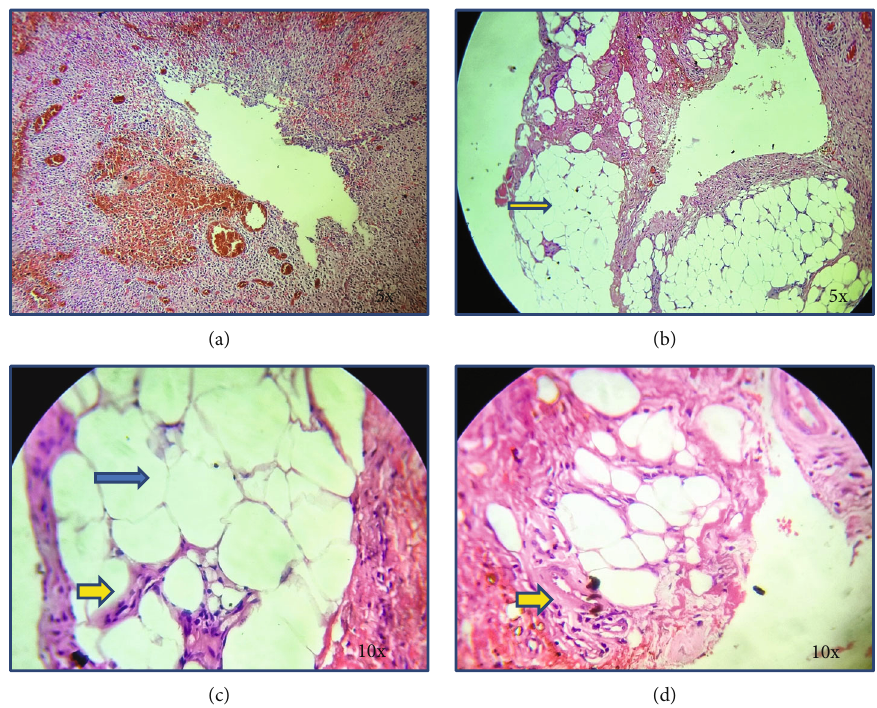
Figure 2: Photomicrograph showing. (a) Stroma showing dispersed chronic in fl ammation with few areas of degeneration (5 × magni fi cation). (b) Mature adipocytes in a lobule separated by thin connective tissue septa (yellow arrow) (5 × magni fi cation). (c) Minimal presence of in fl ammation (yellow arrow), mature adipocytes (blue arrow) (10 × magni fi cation). (d) Compressed blood vessels in between the lobules (yellow arrow) (10 × magni fi